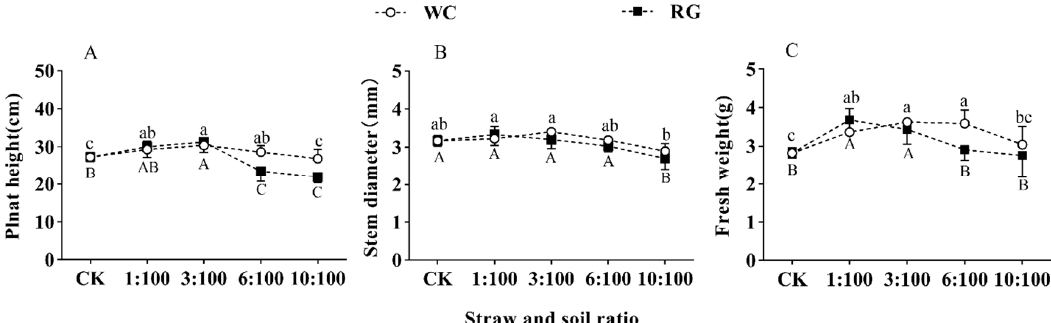
Figure 6. Straw returning on seedlings morphological properties (( A ) Plant height,( B ) Stem diam- eter, ( C ) Fresh weight). Different upper- and lower-case letters represent significant differences ( p < 0.05) between treatments in RG and WC, respectively. The symbol represents mean values of 5 replicates ± SD.